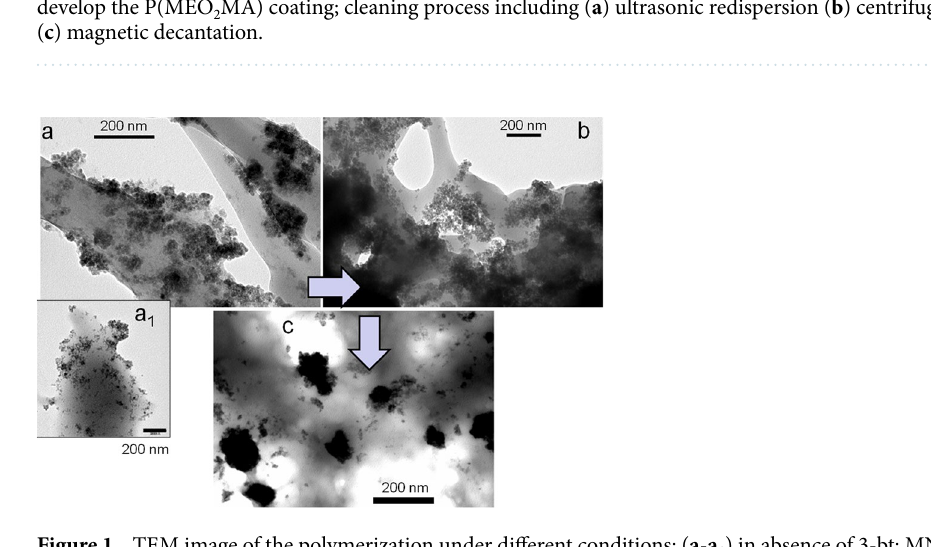
acid, ξ potential about − 35 mV) and the positive charge found in the synthesis bath (ξ potential measurements during the synthesis changed from − 35 mV (citric acid MNPs) to + 15 mV (end of the synthesis)). This can be explained by the positive charge density due to the presence of the cationic azo-initiator AAPH, which would lead to an increased surface interaction between the polymer and the MNPs. These interactions could arise from electrostatic attraction and lead to the formation of composites of polymer coated with MNPs that exhibit low colloidal stability which would then sediment rapidly. Conversely, when 3-bt is added to the system without heating to 70 °C (i.e. at room temperature), large composites are formed with the MNPs embedded inside the polymeric matrix in a heterogeneous composite (Fig. 1b). The vinyl functionality from the 3-bt allows the MNPs to be embedded into the thermoresponsive hydrogel. When the polymerization is developed with MNPs, 3-bt and CTAB at room temperature, the MNPs are grouped inside the polymeric matrix involving the formation of magnetic microclusters embedded inside the microgel with relatively homogeneous sizes between 100–200 nm (See Fig. 1c). Consequently it is likely that the effect of the 3-butenoic acid is to promote the polymerization process on the surface of the MNPs hence enabling the MNPs to be embedded inside the polymeric matrix (Fig. 1b), while electrostatic forces are respon- sible of the coating of MNPs on the polymeric surface (P(MEO 2 MA)@ Fe 3 O 4 ) (Fig. 1a-a1). Moreover, the effect of CTAB in this system is to stabilize the modified MNPs with 3-bt into larger entities. Similarly to a previously work based on gold NPs as cores 37 , the CTAB could coat the MNPs with a thick hydrophobic bilayer, allowing the confinement of the 3-bt acid within the layer and anchoring the vinyl groups on the external surface of the MNPs. Under these conditions, large composite materials are formed in a non-colloidal state. However, at 70 °C the hybrid (Fe 3 O 4 @P(MEO 2 MA) microgels are developed in a precipitation polymerization process where the polymer is insoluble and precipitates as explained below. Thermoresponsive P(MEO MA) coating. By increasing the temperature to 70 °C, the 3-bt will serve as 2 anchor points providing the MNPs with vinyl functionality, so that they become, by themselves, "polymeriza- tion macroinitiators" of the polymerization of MEO 2 MA in the presence of CTAB 37 . Under these conditions,